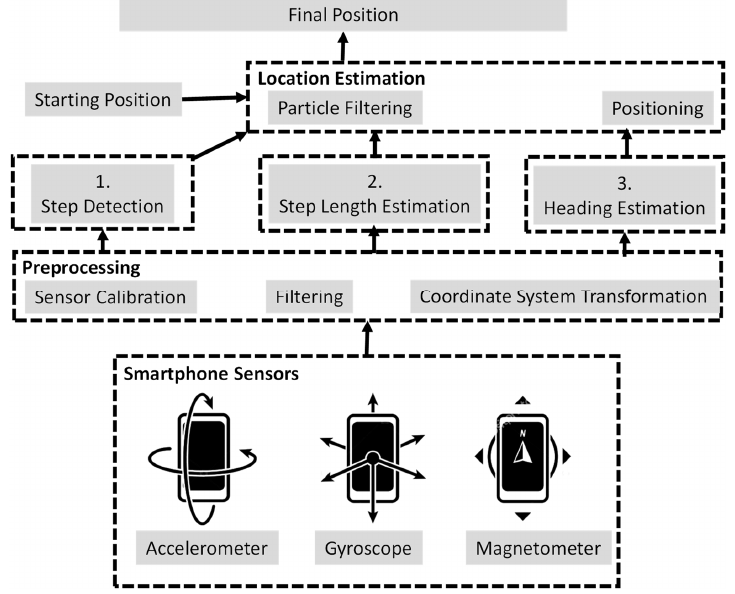
Figure 2. Illustration of the PDR-based IL method.